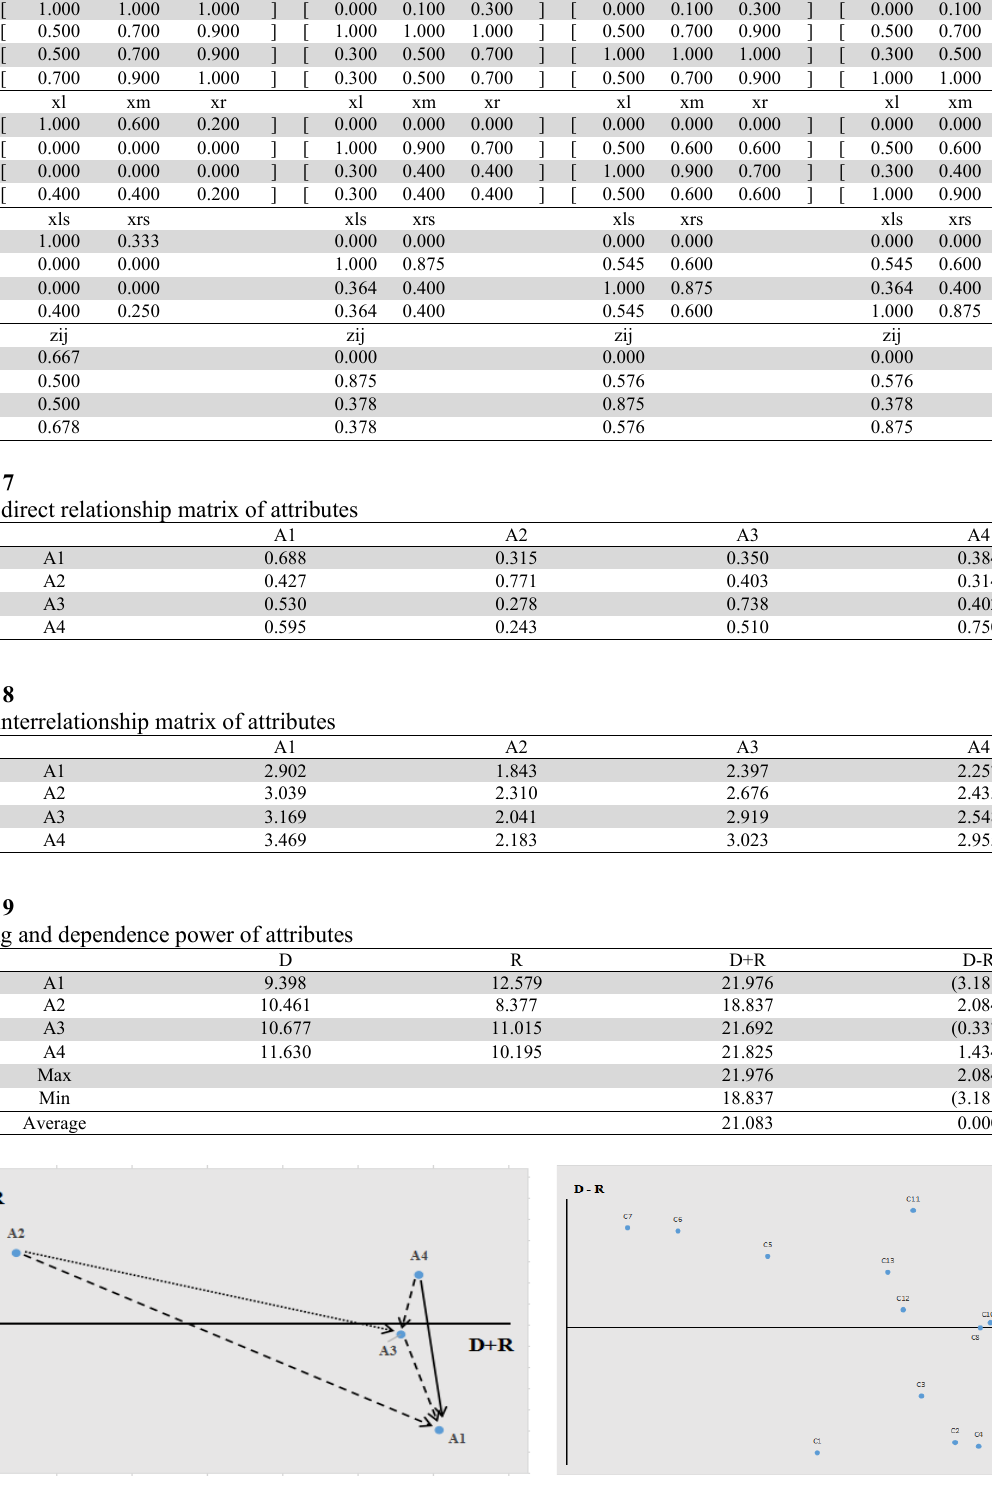
Fig 1. Causal interrelationships diagram among the aspects Fig 2. Cause and effect diagram of criteria for practical